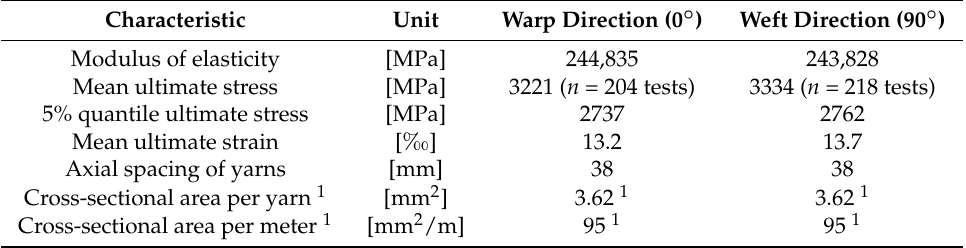
Table 2. Reinforcement characteristics for solidian Grid Q95/95-CCE-38 (properties of one individual yarn, from [64] with test setup according to [65]). Characteristic Unit Warp Direction (0 ◦ ) Weft Direction (90 ◦ ) Modulus of elasticity [MPa] 244,835 243,828 Mean ultimate stress [MPa] 3221 ( n = 204 tests) 3334 ( n = 218